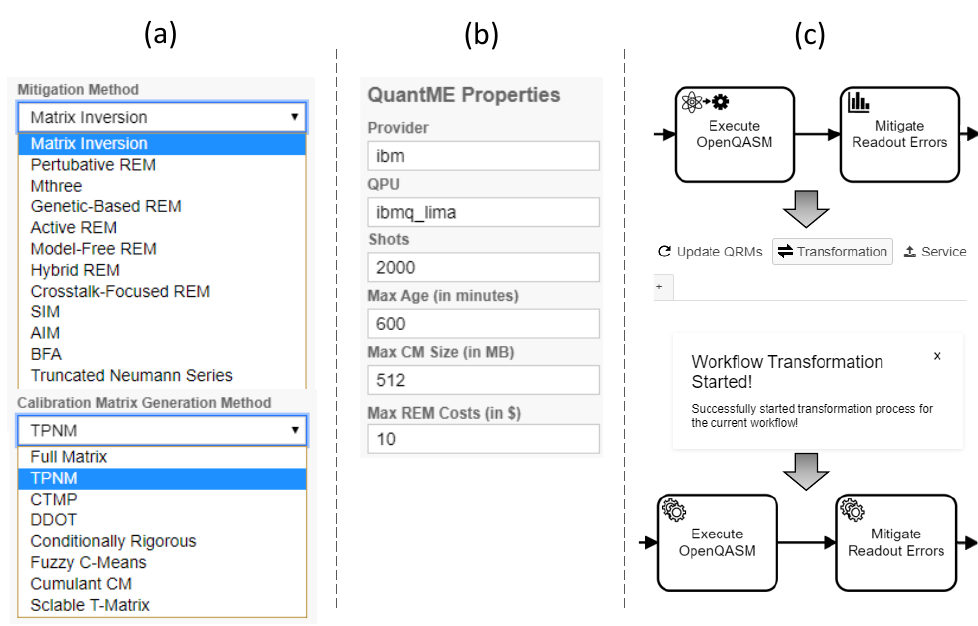
Figure 9. REM method selection ( a ), configuration ( b ), and workflow transformation ( c ) for our case study.